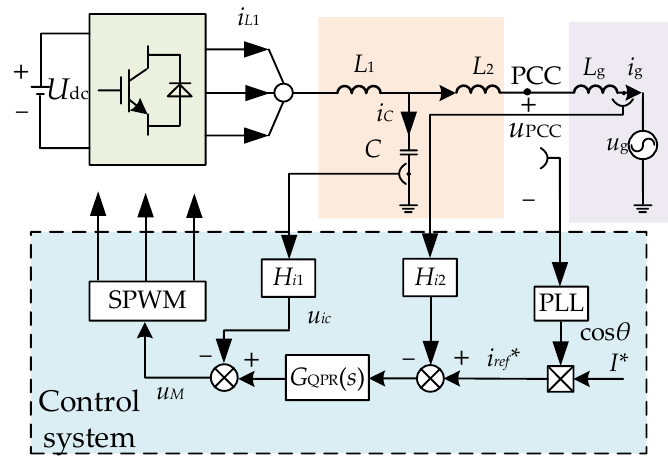
Figure 1. A structure diagram of an LCL inverter.